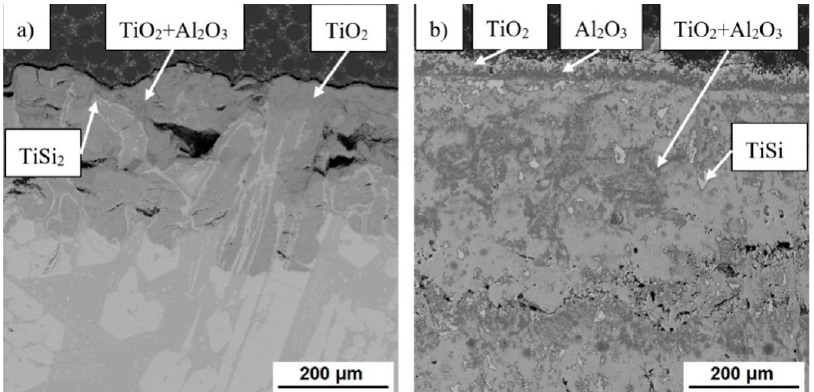
Figure 10. Microstructure (SEM-BSE) of oxide layers of TiAl15Si15 alloy, prepared by centrifugal casting, after cyclic oxidation at ( a ) 800 ◦ C and ( b ) 1000 ◦ C for 400